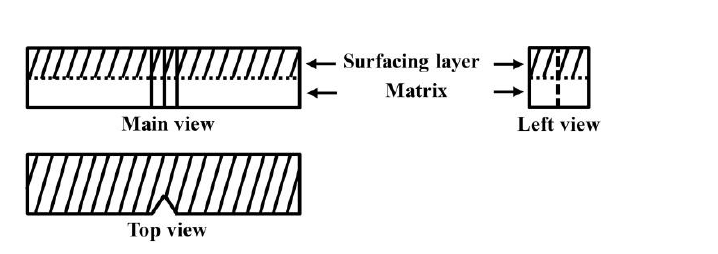
Figure 2. Chart of impact specimen. Table 4. The Rockwell hardness of the matrix and the different types of surfacing layer (HRC).